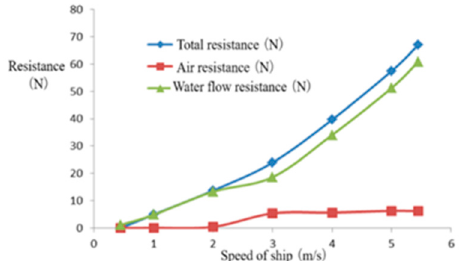
Figure 4. Relationship between water or air resistance and ship speed.